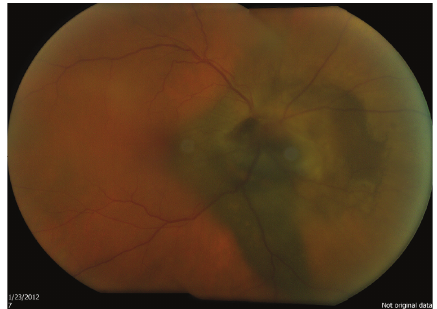
Figure 6: Fundus photograph after 6